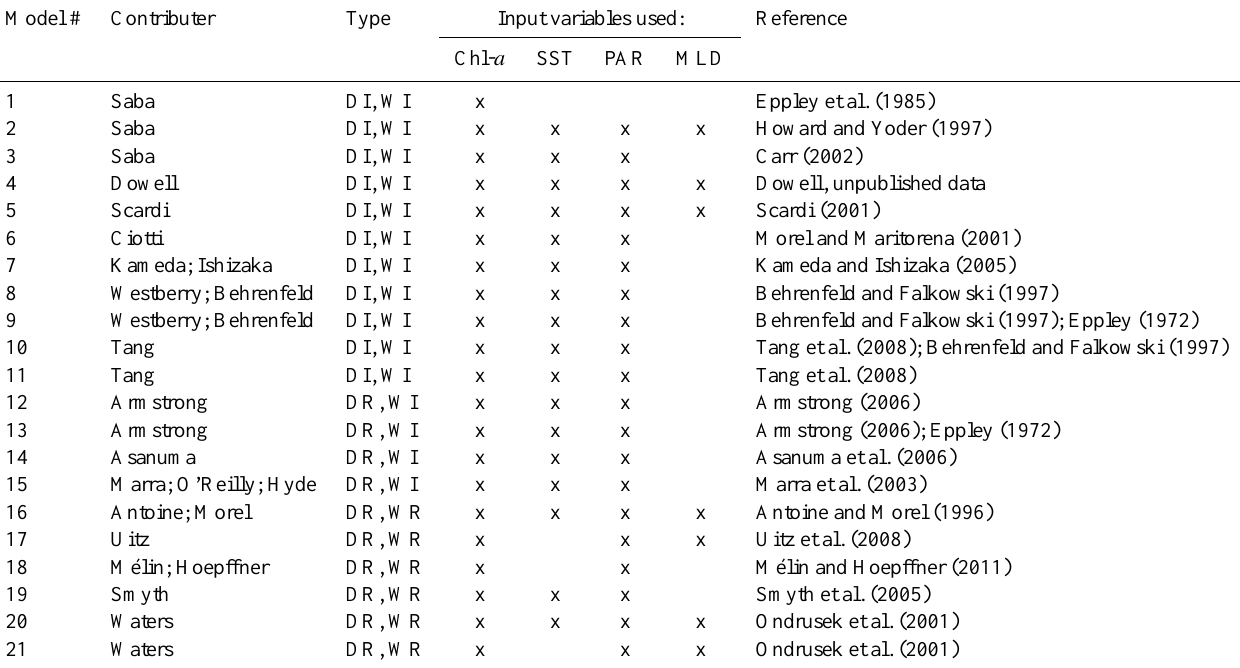
Table 2. Contributed satellite-based ocean color primary productivity models. Specific details for each model are described in Appendix A of the